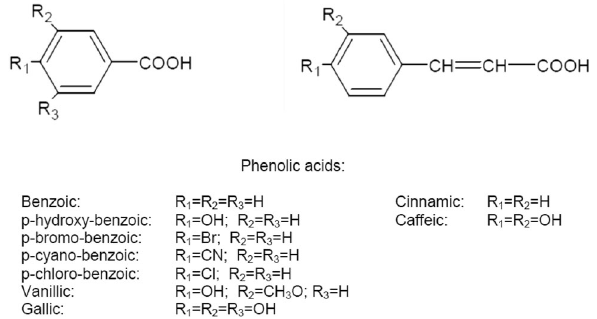
Fig. 1 Basic chemical structures of phenolic